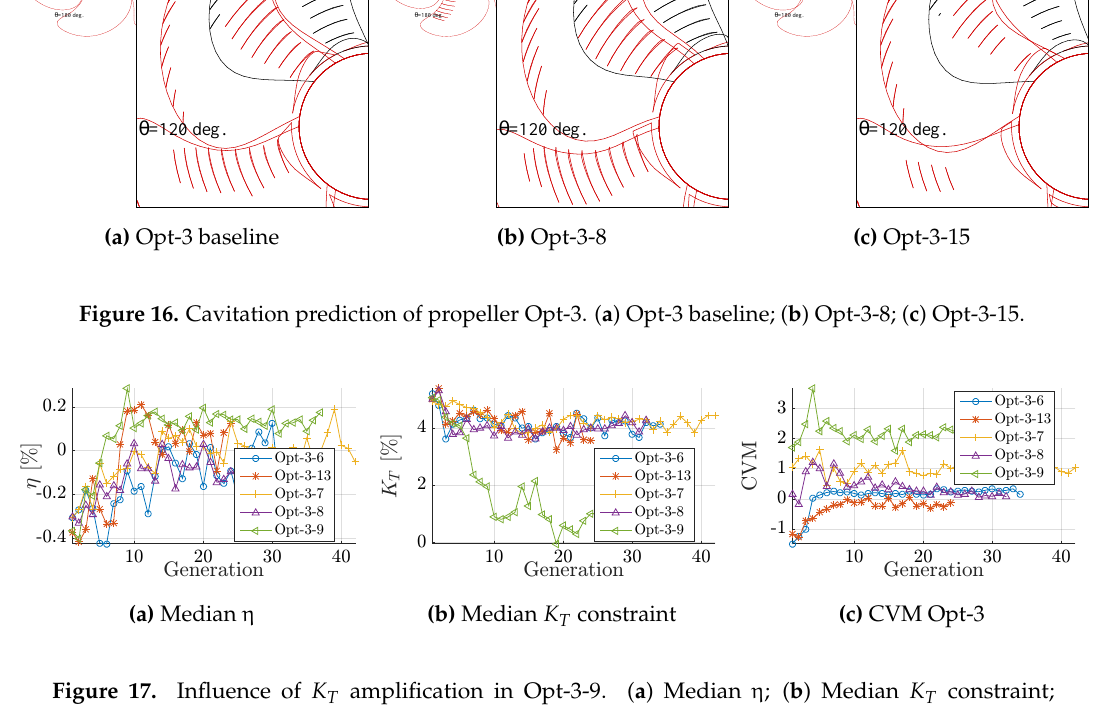
Figure 17. Influence of K T amplification in Opt-3-9. ( a ) Median η ; ( b ) Median K T constraint; ( c ) CVM